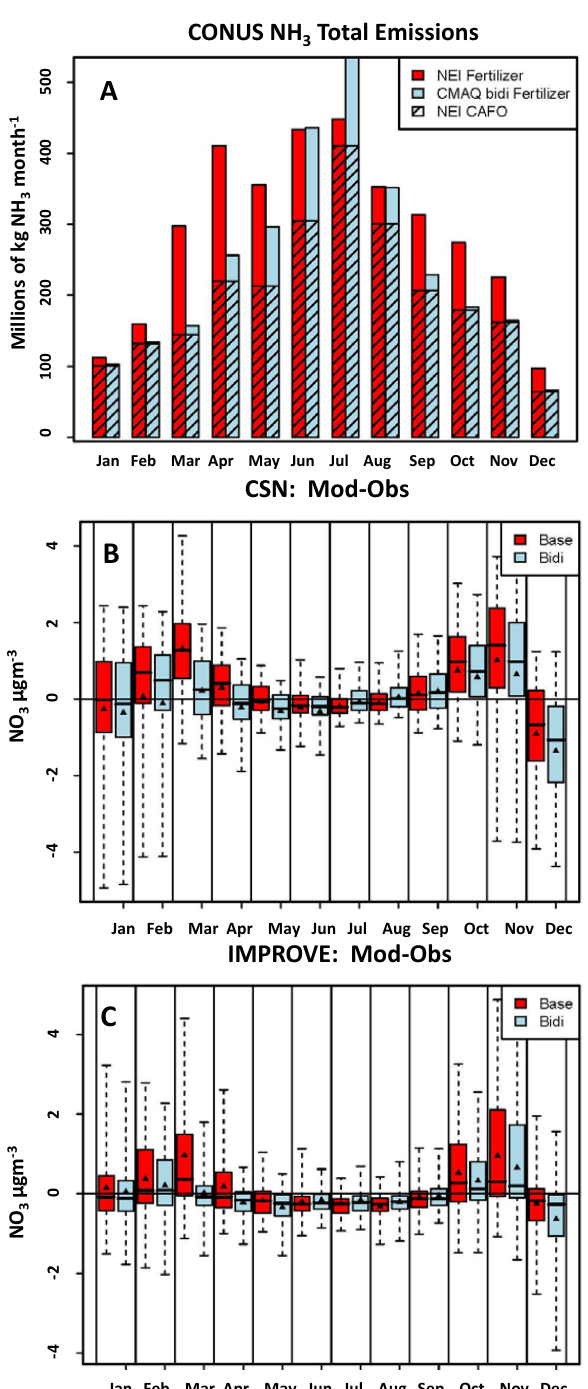
Fig. 7. (A) Monthly total NH 3 emissions (Confined Animal Feeding Opera- tions(CAFO), industrial, mobile, and inorganic fertilizer) reported in the 2005 US EPA NEI and estimated by the bi-directional CMAQ with EPIC fertilizer for the Continental US (CONUS), (B) monthly model ambient NO − 3 biases for 2002 at urban CSN obser- vation sites, and (C) rural IMPROVE observation sites. In (B) and (C) , red indicates base model simulations and blue indicates bi-directional CMAQ with EPIC fertilizer, the black line within the box represents the median bias, shaded areas represent the range of the 25% to 75% quartile, the whiskers represent the range of 5% and 95% quantiles, and the black triangle represents the mean